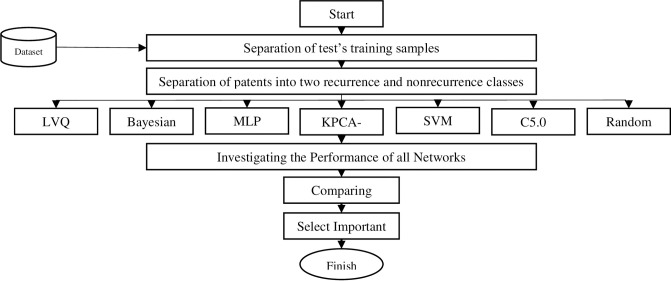
The exploited algorithm in this study.